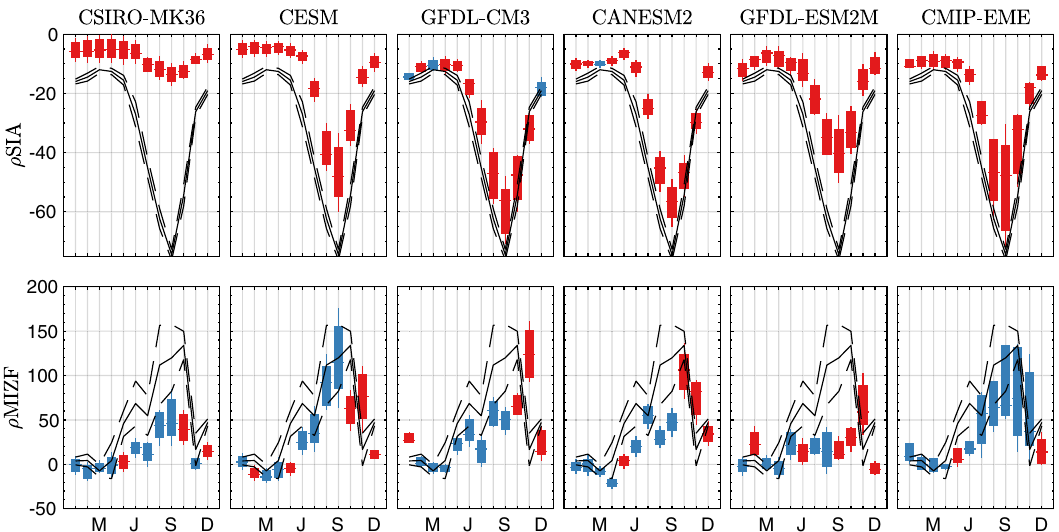
Fig. 3 Seasonal plausibility of GCM estimates of SIA/MIZF sensitivity. (Top row) Seasonal cycle of sea ice sensitivity ρ SIA (units %/K), for CLIVAR-LE members or CMIP6-EME over 1979 – 2014. Boxes cover the interquartile range and horizontal whiskers the ensemble median. Vertical whiskers extend to ±3 σ from the ensemble mean (95% of normally distributed data). Black solid line is the mean from observations. Dashed lines bound observational uncertainty (see “ Methods ” ). Red shaded boxes are implausible estimates of sensitivity, and blue are plausible estimates (see “ Methods ” ). (Bottom row) Same, but for MIZF sensitivity ρ MIZF (units